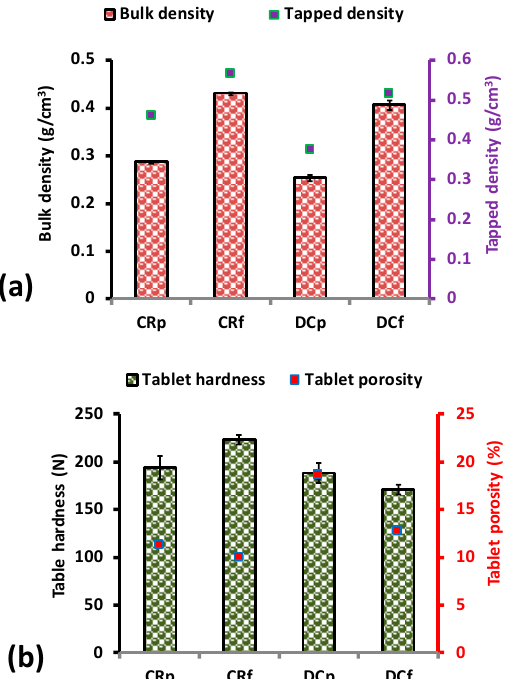
Figure 2. Bulk and tapped densities of polymer and formulated blends of CR and DC ( a ), tablet compact properties of hardness and porosity and for the polymers and formulated blends of CR and DC ( b ). Note: CRp is the pure CR polymer, CRf is CR formulation as detailed in Table 1, DCp is the pure DC polymer, DCf is the DC formulation as in Table 1. “Pure” in this context means the actual polymer with no active pharmaceutical ingredient (API) or